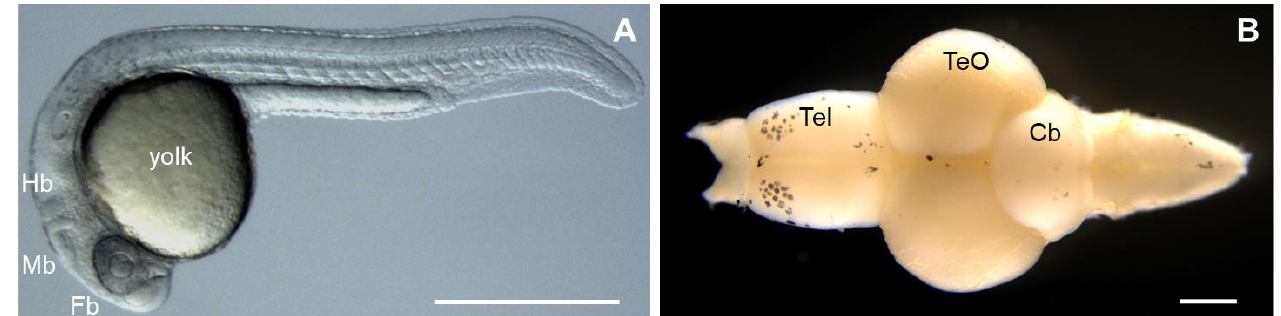
Figure 1. Major features of the zebrafish ( Danio rerio ). ( A ) Zebrafish embryo at day 1 of development. Fb, forebrain; Mb, midbrain; Hb, hindbrain. ( B ) Dissection of brain from an adult zebrafish. Tel, telencephalon; TeO, optic tectum; Cb, cerebellum. Rostral part of the brain is pointing to the left. Scale bars: 500 µm.